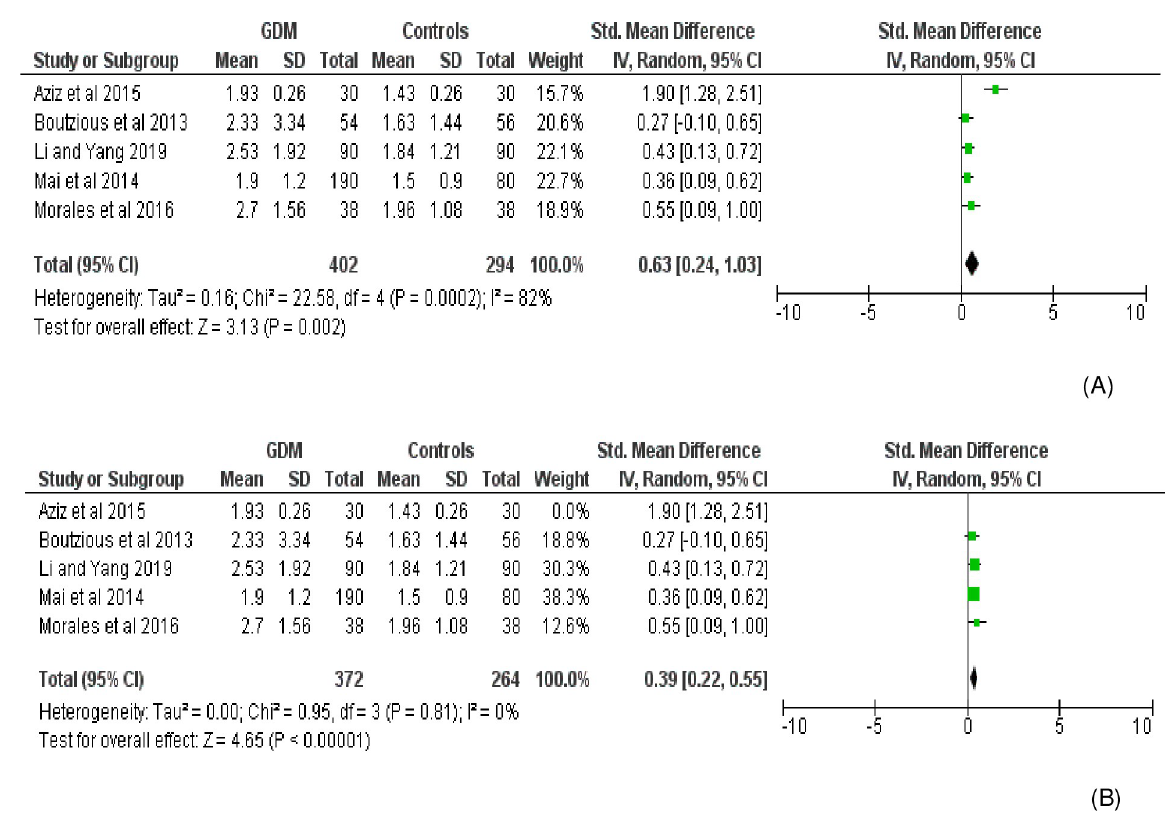
Fig 4. Forest plot comparing the level of HOMA-IR among women with GDM and pregnant controls. (A) without sensitivity analysis (B) with sensitivity analysis.